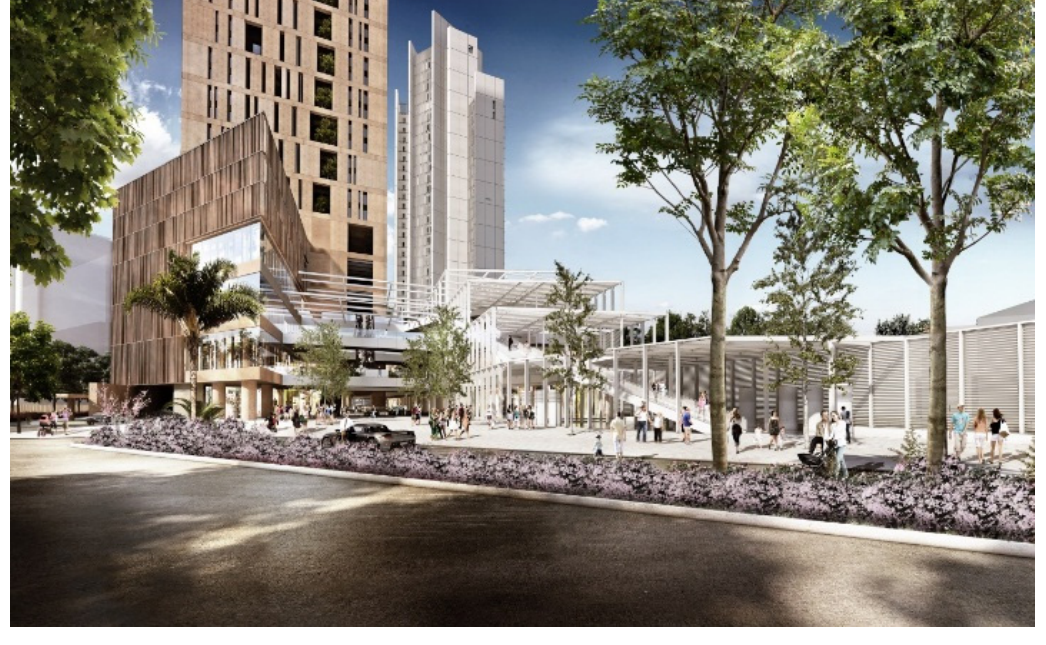
Figure 11. External View of Ege Perla Towers. Reproduced with permission from Emre Arolat